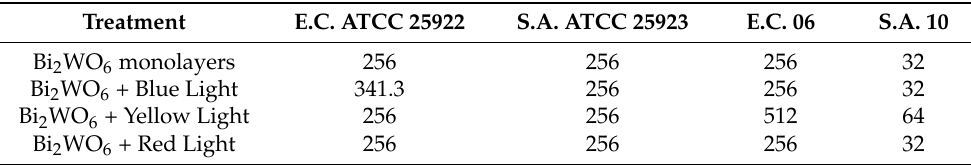
Table 2. MIC of layered Bi 2 WO 6